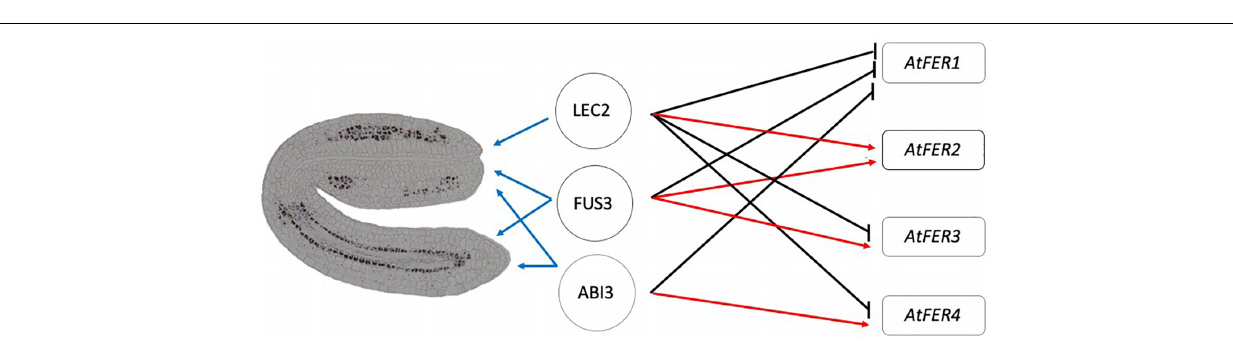
FIGURE 5 | FERRITINs are deregulated in B3 transcription factors mutants. (A) FERRITINs transcripts accumulation in green cotyledon stage (M) and in dry seeds (D). T -test was performed, P -value < 0.05, * p < 0.05, ** p < 0.01 and *** p < 0.001. (B) Protein accumulation of FERRITINs in dry seeds. 10 µ g of proteins were loaded in each well. Poly-clonal antibody detecting all four FERRITINs was used. As loading control the membrane was stained with Coomassie Blue.